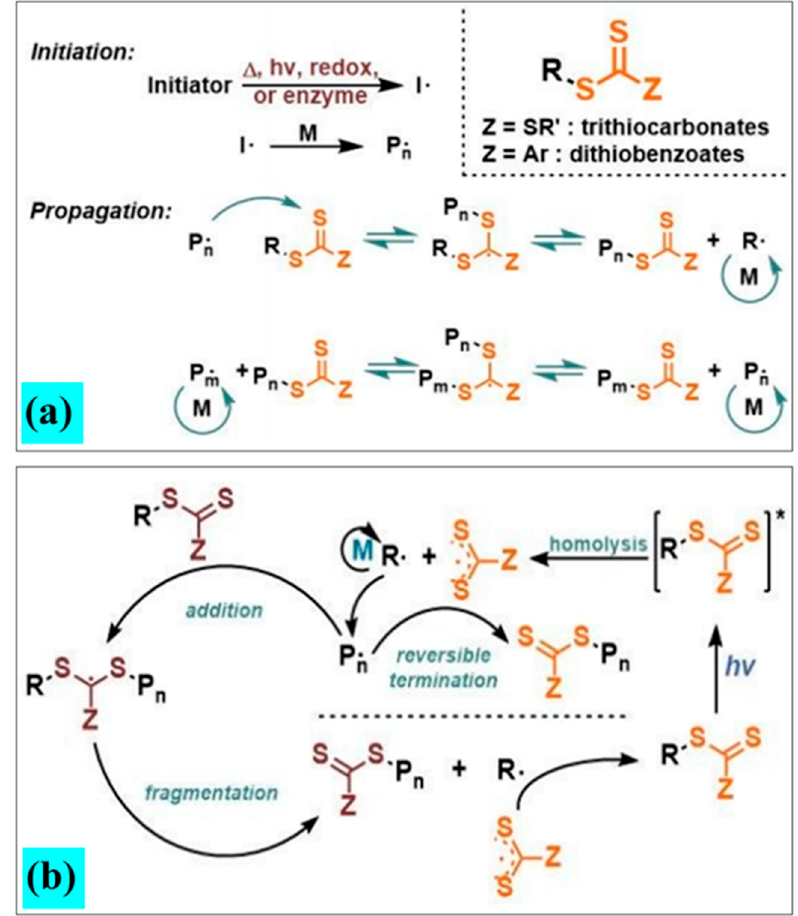
Figure 3. ( a ) The general mechanism for “living” radical polymerization, involving thiocarbonylthio compounds. ( b ) The general mechanisms for photoinduced RAFT polymerization, in which RAFT agents are initiators and CTAs simultaneously [39].